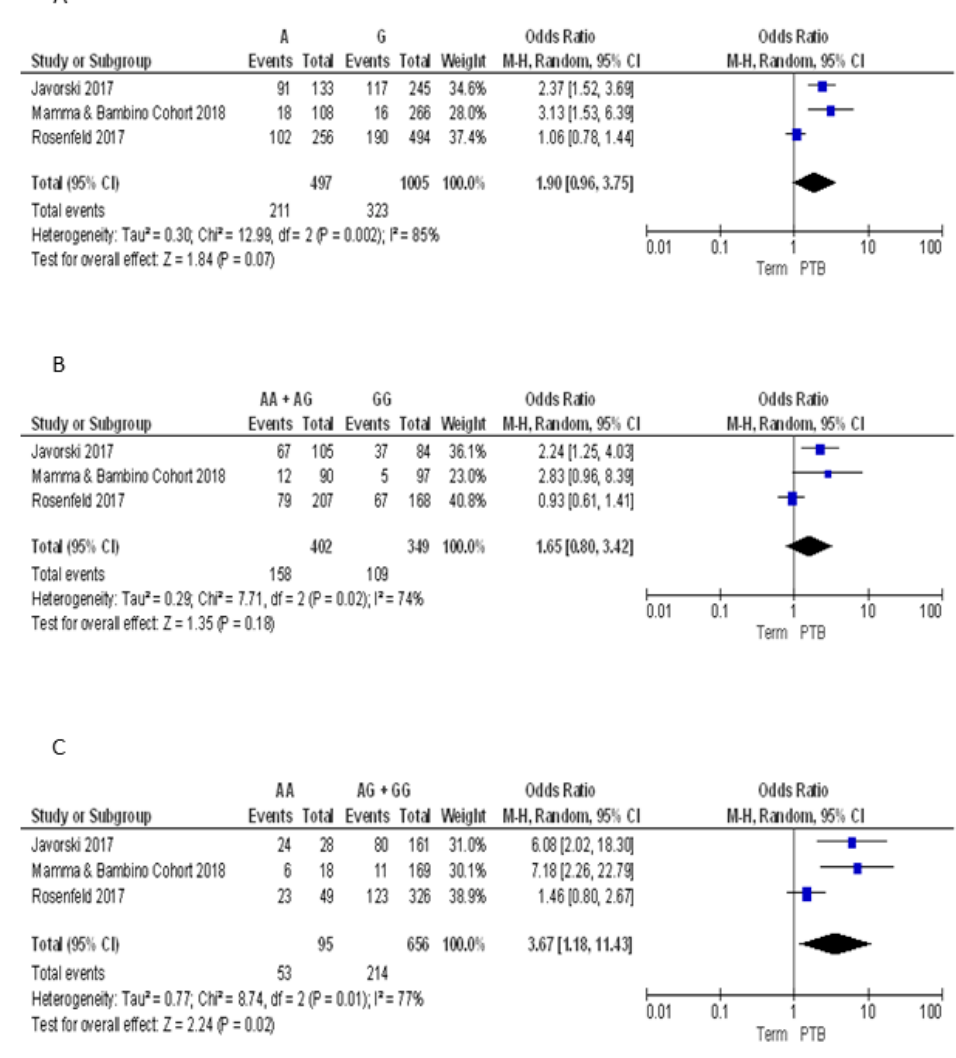
Figure 5. Forest plots of the association between FokI polymorphism and preterm birth under the ( A ) allelic, ( B ) dominant and ( C ) recessive models.